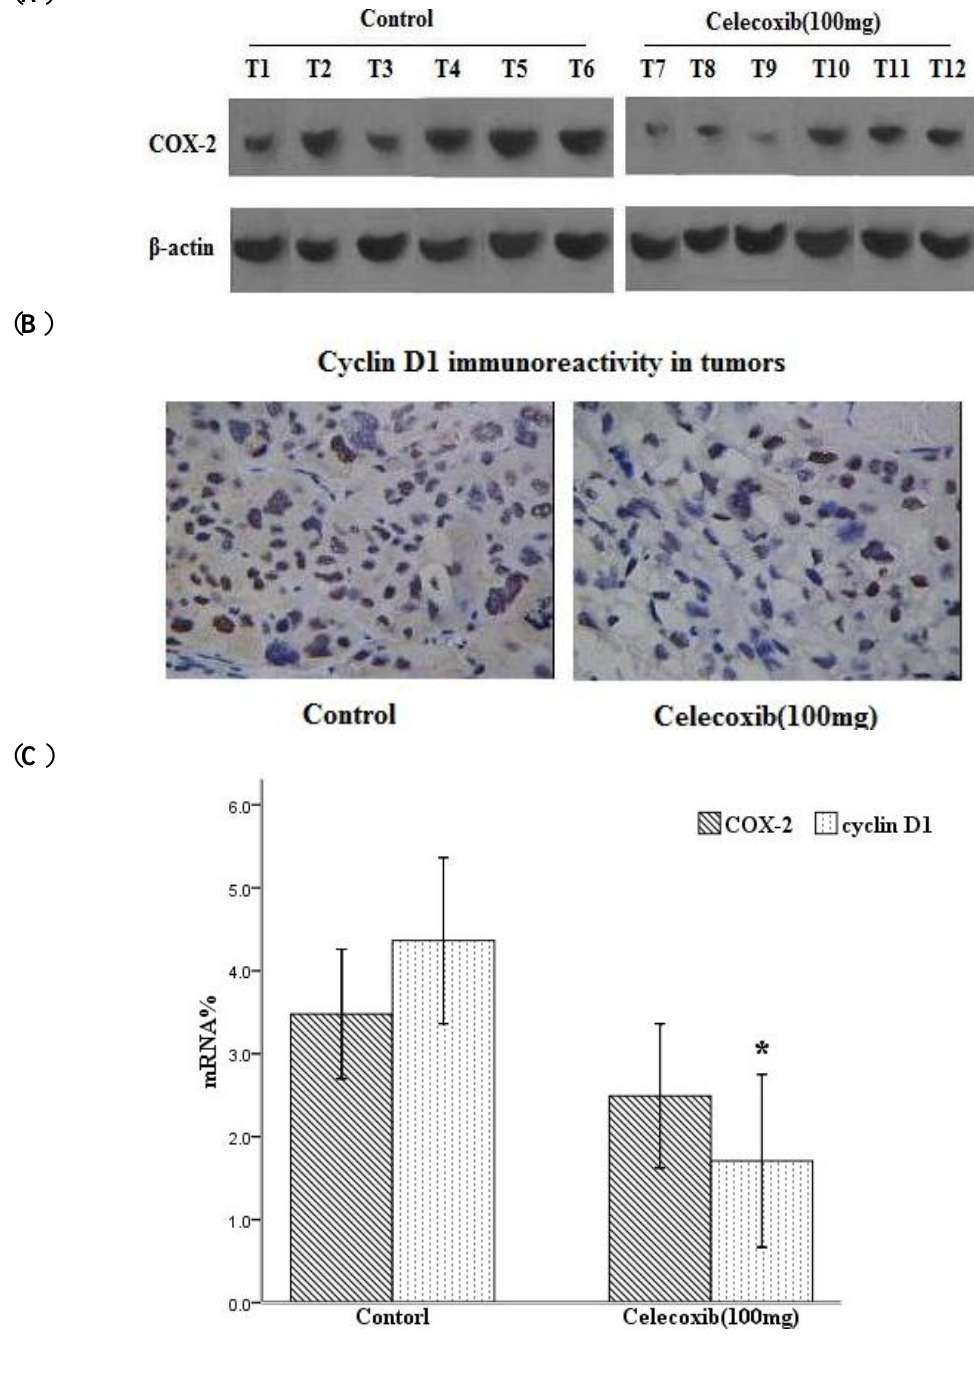
Figure 1. Effects of Celecoxib on COX-2 and cyclin D1 activation in SKOV-3 xenograft tumors: ( A ) Western blot analysis of SKOV-3 tumors treated with a high-dose of Celecoxib (100 mg/kg). Tumor cells lysate protein from six control mice (T1–T6) and six Celecoxib-treatment mice (T7–T12); ( B ) Representative pictures of cyclin D1 immunohistochemical staining of tumors. Magnification is ×400; ( C ) mRNA levels of COX-2 and cyclin D1 detected by RT-PCR. The results show that both COX-2 and cyclin D1 expression in tumors were decreased in the high-dose Celecoxib treatment group. * P < 0.05 compared with control, error bars indicate